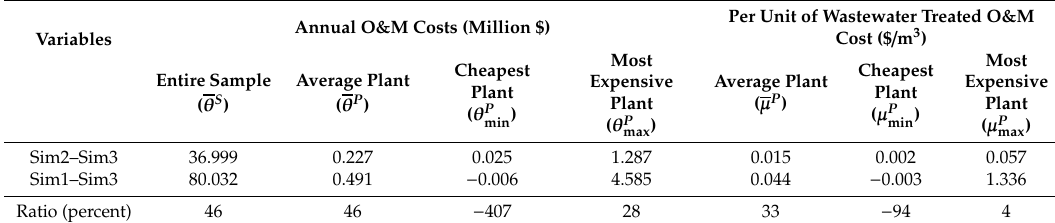
Table 7. Di ff erences in calculated cost measures between scenarios.